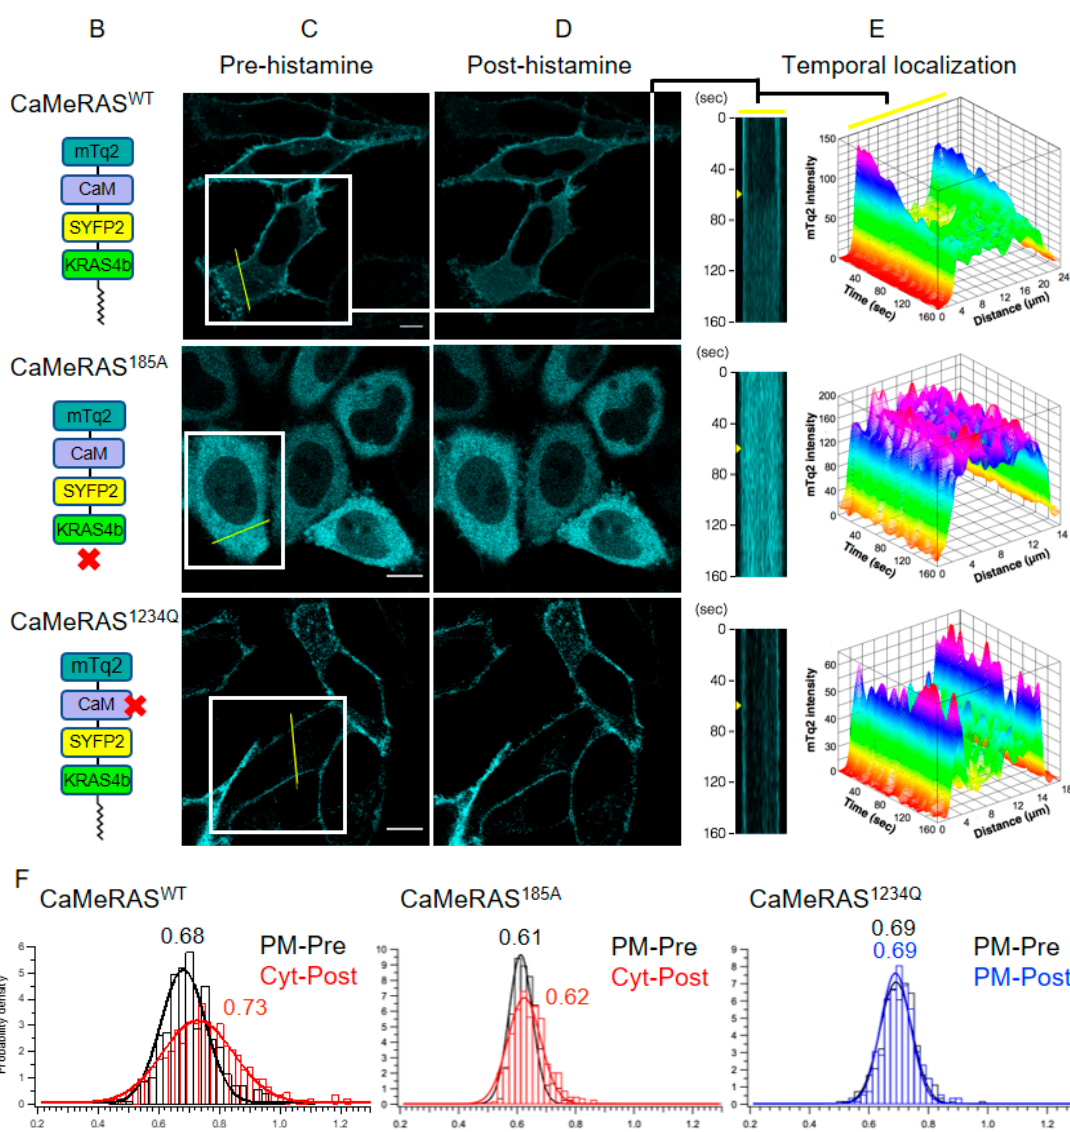
Figure 3. CaMeRAS demonstrates reversible Ca 2+ -/farnesyl-dependent internalization and FRET change. ( A ) Schematic of CaMeRAS and bimodal use for CaM-KRAS4b binding model validation. When transiently expressed in mammalian cells, the chimeric construct is natively processed at the C-terminal CaaX box (i.e., farnesylation of Cys185, cleavage of aaX residues, and carboxymethylation of the new C-terminus), allowing tethering of the construct to the plasma membrane. Upon cytosolic Ca 2+ elevation, Ca 2+ -CaM extracts KRAS4b from the membrane, visible with fluorescence imaging, and the structural rearrangement of the chimera leads to detectable FRET. ( B ) Schematic of CaMeRAS variants transiently expressed in each experiment: CaMeRAS WT (comprised of wild-type CaM and KRAS4b), CaMeRAS 185A (KRAS4b Cys185 mutated to Ala to prevent farnesylation), and CaMeRAS 1234Q (a key residue involved in coordination of Ca 2+ in each of the four EF hands in CaM was mutated [i.e., E31Q, E67Q, E104Q and E140Q] to impair binding of Ca 2+ . An X indicates where each mutant is deficient. ( C – F ) After loading the cells with 10 µM Calbryte 630AM (AAT Bioquest), imaging was performed at room temperature using a Leica SP8 confocal microscope with a 63x/1.4 numerical aperture (NA) oil immersion objective lens and high-sensitivity HyD detectors. For simultaneous visualization of mTq2, SYFP2, and Calbryte 630, a 440-nm solid state laser and a white light laser tuned to 608 nm were used for excitation of mTq2 and Calbryte 630, respectively, and fluorescence emission was collected at 455 to 490 nm (mTq2), 525 to 560 nm (SYFP2), and 620 to 750 nm (Calbryte). Images were acquired at 3.4 to 4.0 s per frame. ( C ) Cellular localization (mTq2) of